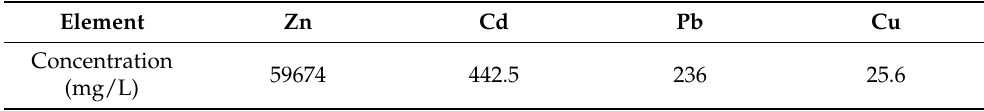
Table 3. The chemical composition of the leachate. Element Element